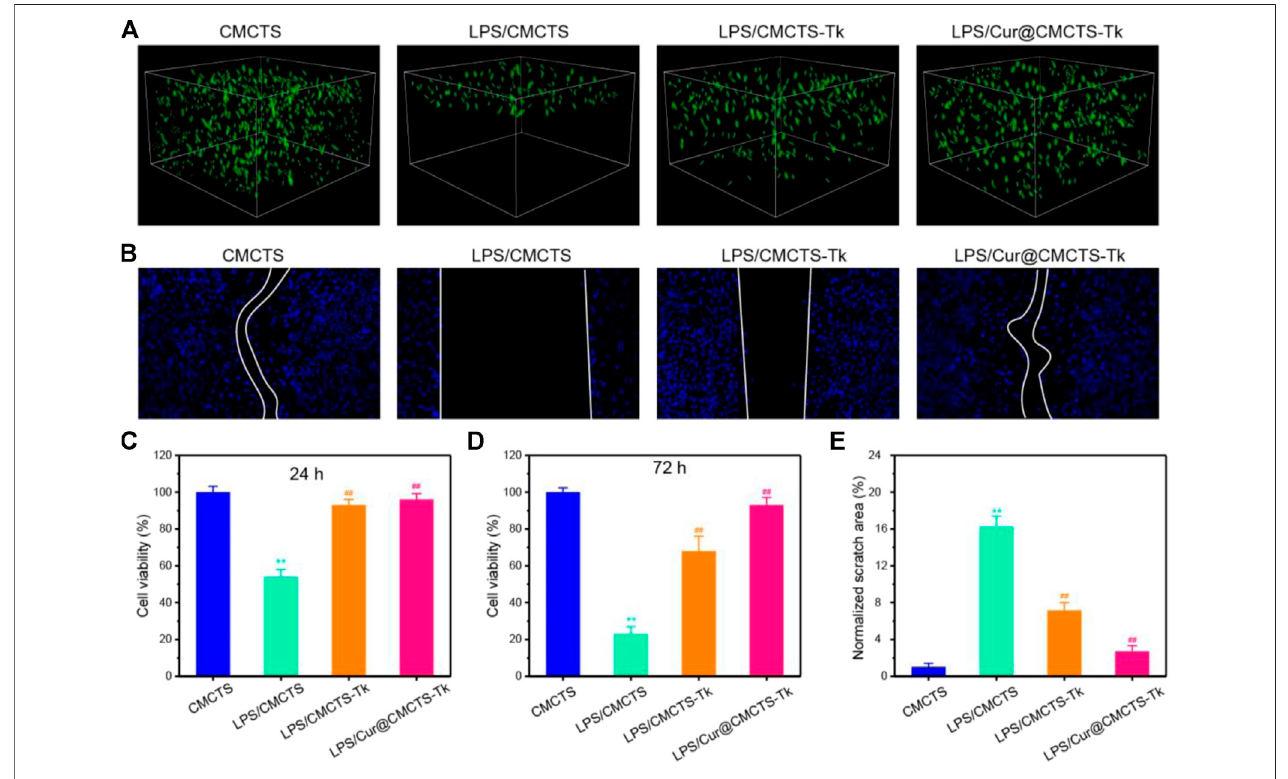
FIGURE4|(A) TheGFP-plasmidtransfectedcellswereculturedwithCMCTS(Control),LPS/CMCTS(LPS),LPS/CMCTS-Tk,andLPS/Cur@CMCTS-Tkhydrogel for 72 h. (B) Images for cell wound scratch assay ofL929 cells at 72 h. (C) Cytotoxicity of Cur@CMCTS-Tk hydrogel to fi broblastcells by MTT assayat 24and 72 h. (D) Quantitative analysis of the scratch area. The data were represented as mean ± SD ( n (cid:2) 6), ** p < 0.01 vs. control; ## p < 0.01 vs. LPS/CMCTS (LPS) group.